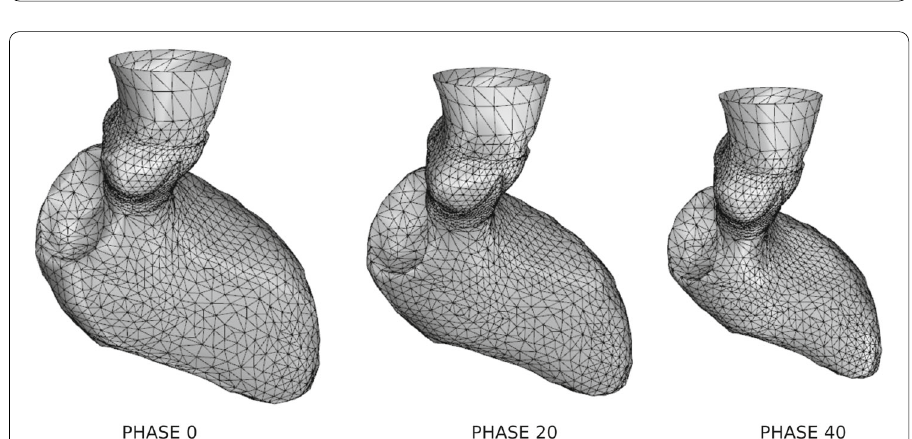
Fig. 17 Real-time data-based model. Geometry is evaluated from the built reduced order model. Row ( a ) left to right: parameters and perspective view. Row ( b ) left to right: parameters and perspective view for different parameters